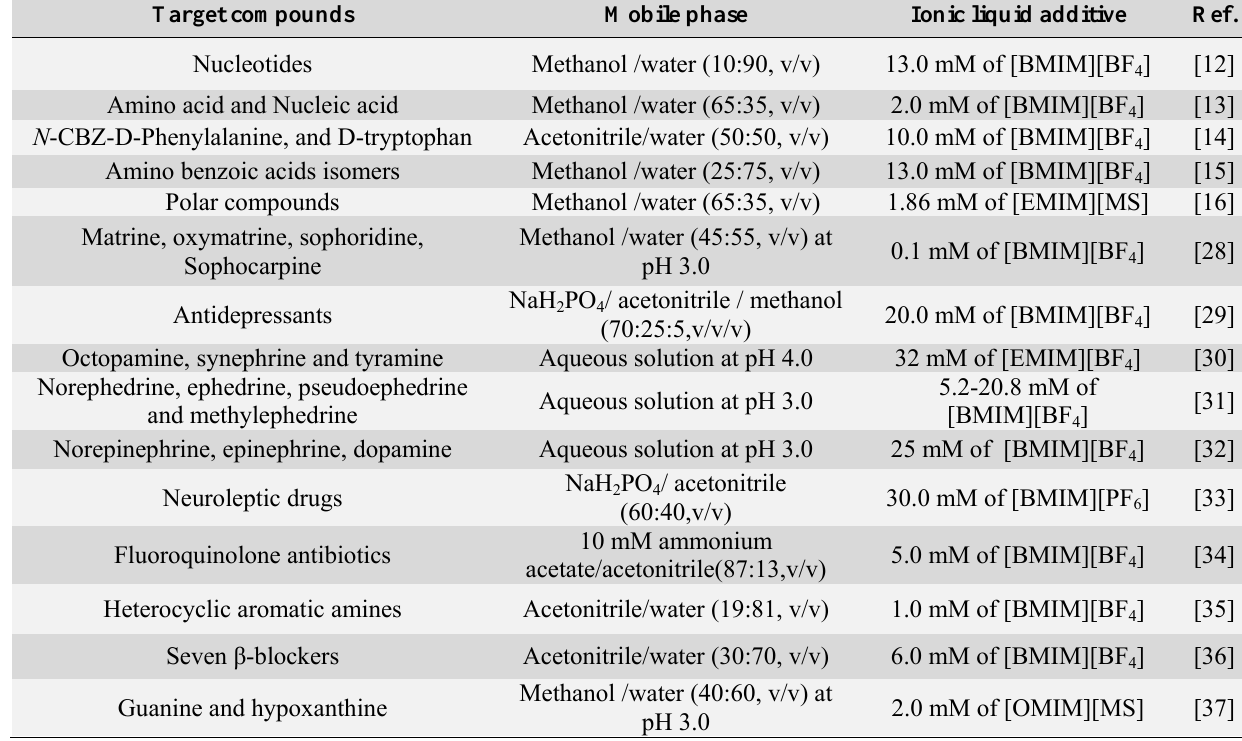
Table 2. Application of ionic liquid as the mobile phase